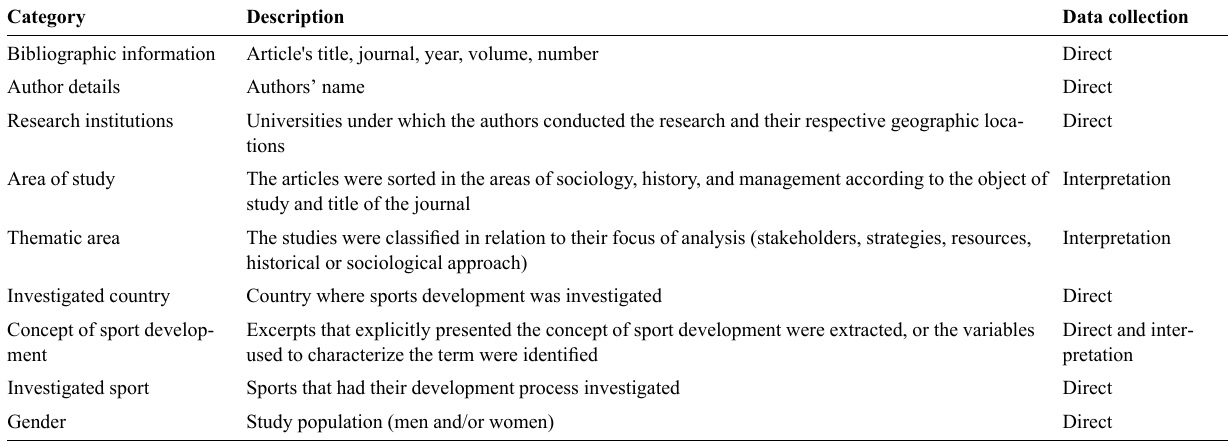
Table 2 - Description of the data and collection method used in this